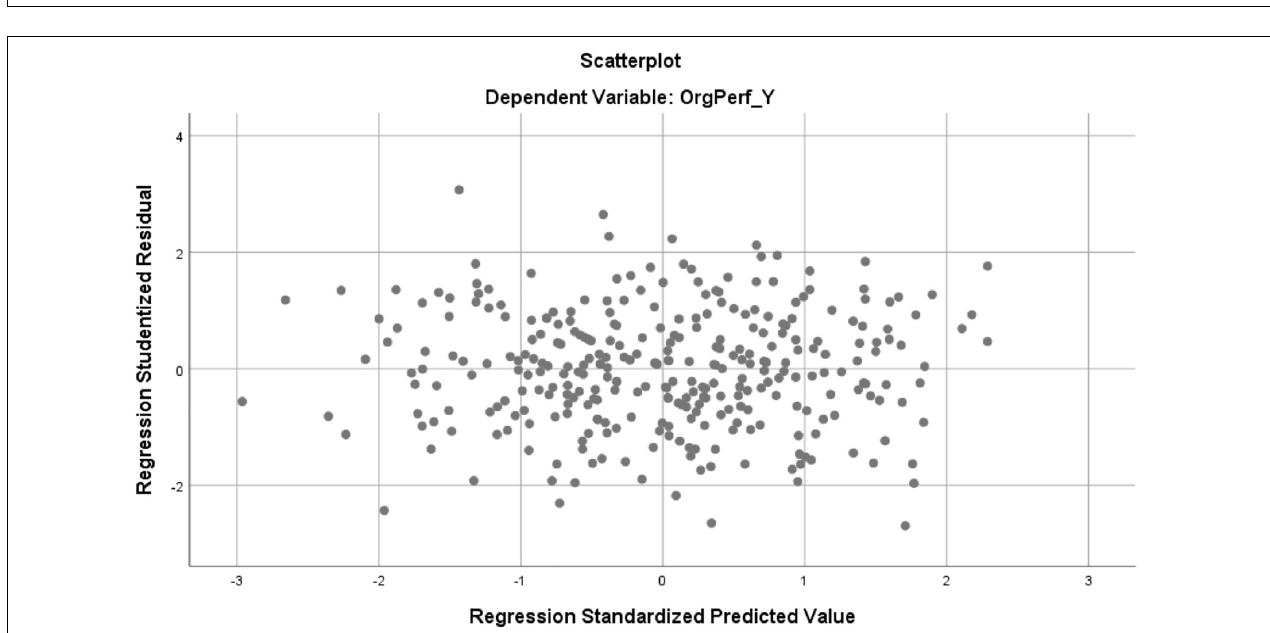
FIGURE 3 | Detrended QQ plot graph of the normality of the residues.